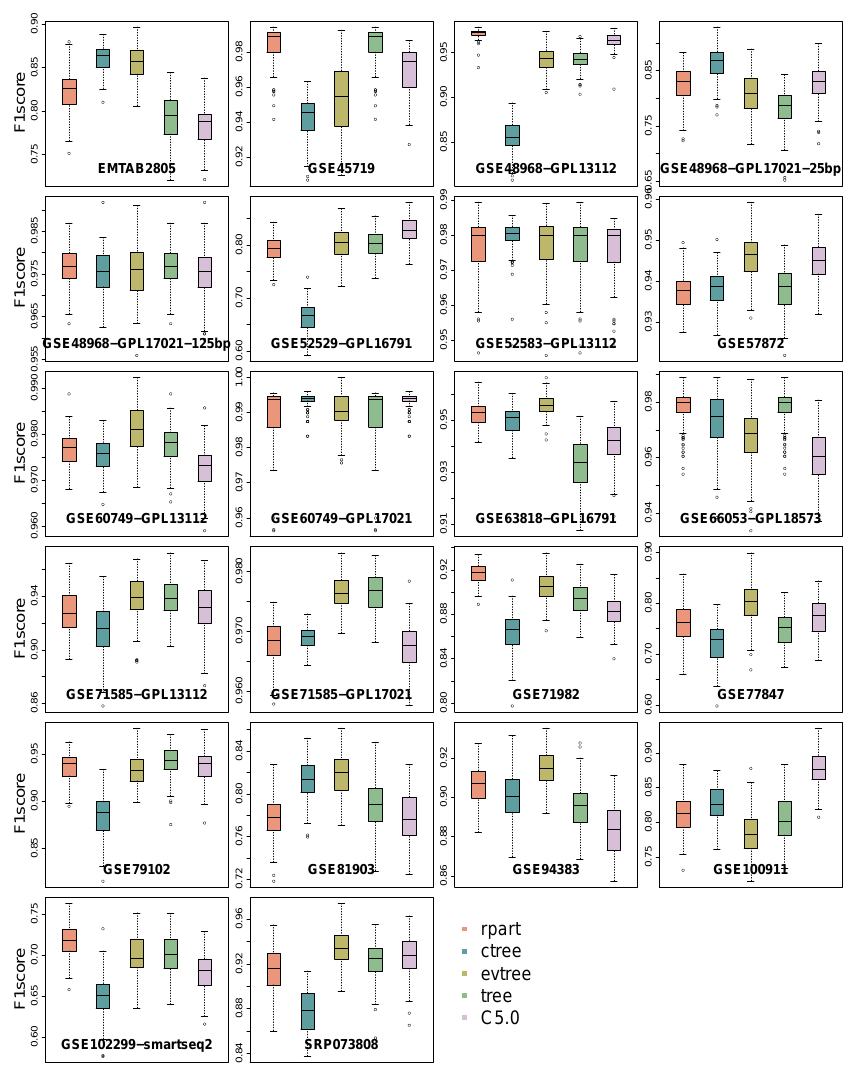
Figure 4. Methods’ F1score scores on all data